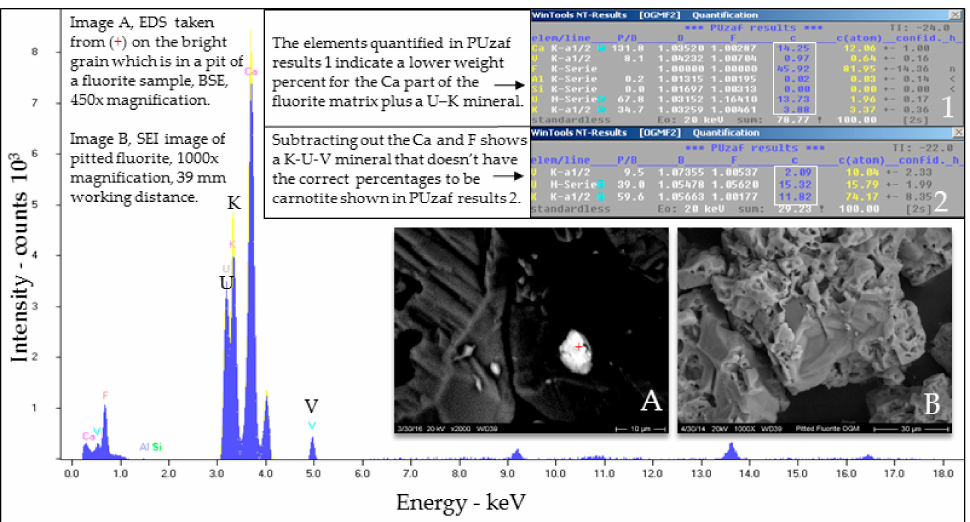
Figure A3. EDS spectrum for Old Glory mine fluorite sample with small grains of a K-U-V mineral. Spectrum taken from the bright grain in image A, BEI image, 2000 × magnification. Pitted grains of fluorite pictured in the image B, from the Old Glory mine, SEI, 1000 × magnification, 39 mm working distance. The presence of these U minerals in the fluorite sample likely account for the U and V concentration in the fluorite samples, Table A2, samples